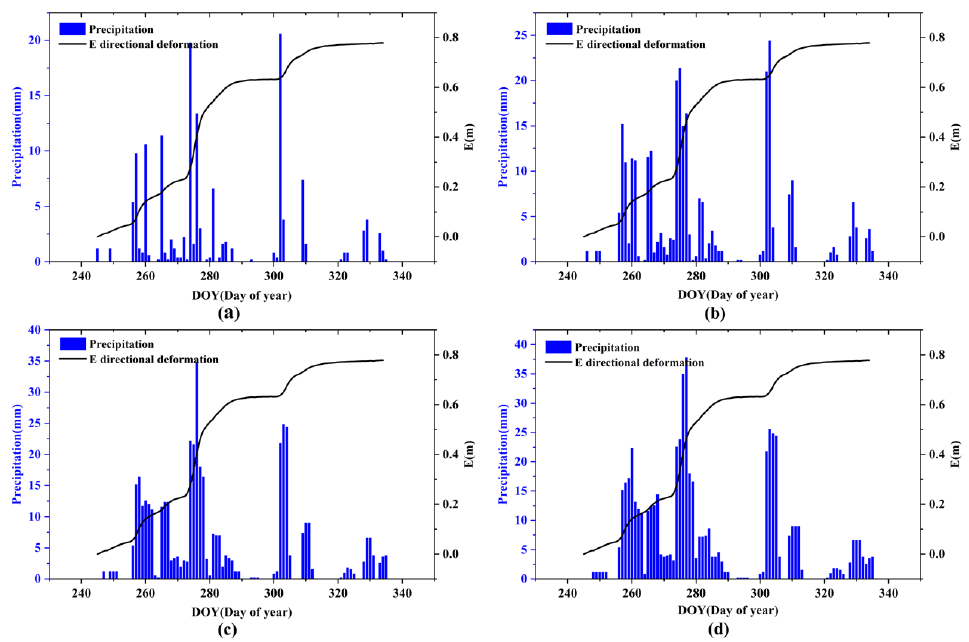
Figure 14. Relationship between deformation and ( a ) single-day rainfall; ( b ) two-day cumulative rainfall; ( c ) three-day cumulative rainfall; and ( d ) four-day cumulative rainfall. To analyse the correlation between landslide deformation and rainfall, the relationship curves between the deformation rate and the factors of single-day rainfall and cumulative rainfall were established for further analysis. In Figure 15, the red and blue bars indicate the deformation rate and rainfall, respectively. The deformation rate reached its peak on days 258, 276, and 304 during the three periods of landslide deformation, which were 0.037, 0.075, and 0.031 m/d, respectively. During this period, the daily rainfall and the cumulative rainfall of two, three, and four days also reached a peak in the period corresponding to the peak deformation rate. In particular, the transformation trend of the cumulative rainfall of three and four days is highly consistent with the changing trend of the deformation rate in the whole period, indicating a strong correlation between the cumulative rainfall and the landslide deformation rate. The results of the lagged correlation analysis between the two results are shown in Figure 16, where the response lag time of deformation rate to single-day, two-day, and three-day cumulative rainfall is 1 day, while the response lag time of deformation rate to four-day cumulative rainfall is 0 days, and With the increase in cumulative rainfall days in the experimental area, the extreme value of the correlation between deformation rate and cumulative rainfall also increases continuously, and the extreme value of the correlation between deformation rate and four-day cumulative rainfall reached 0.8, a significantly high correlation.